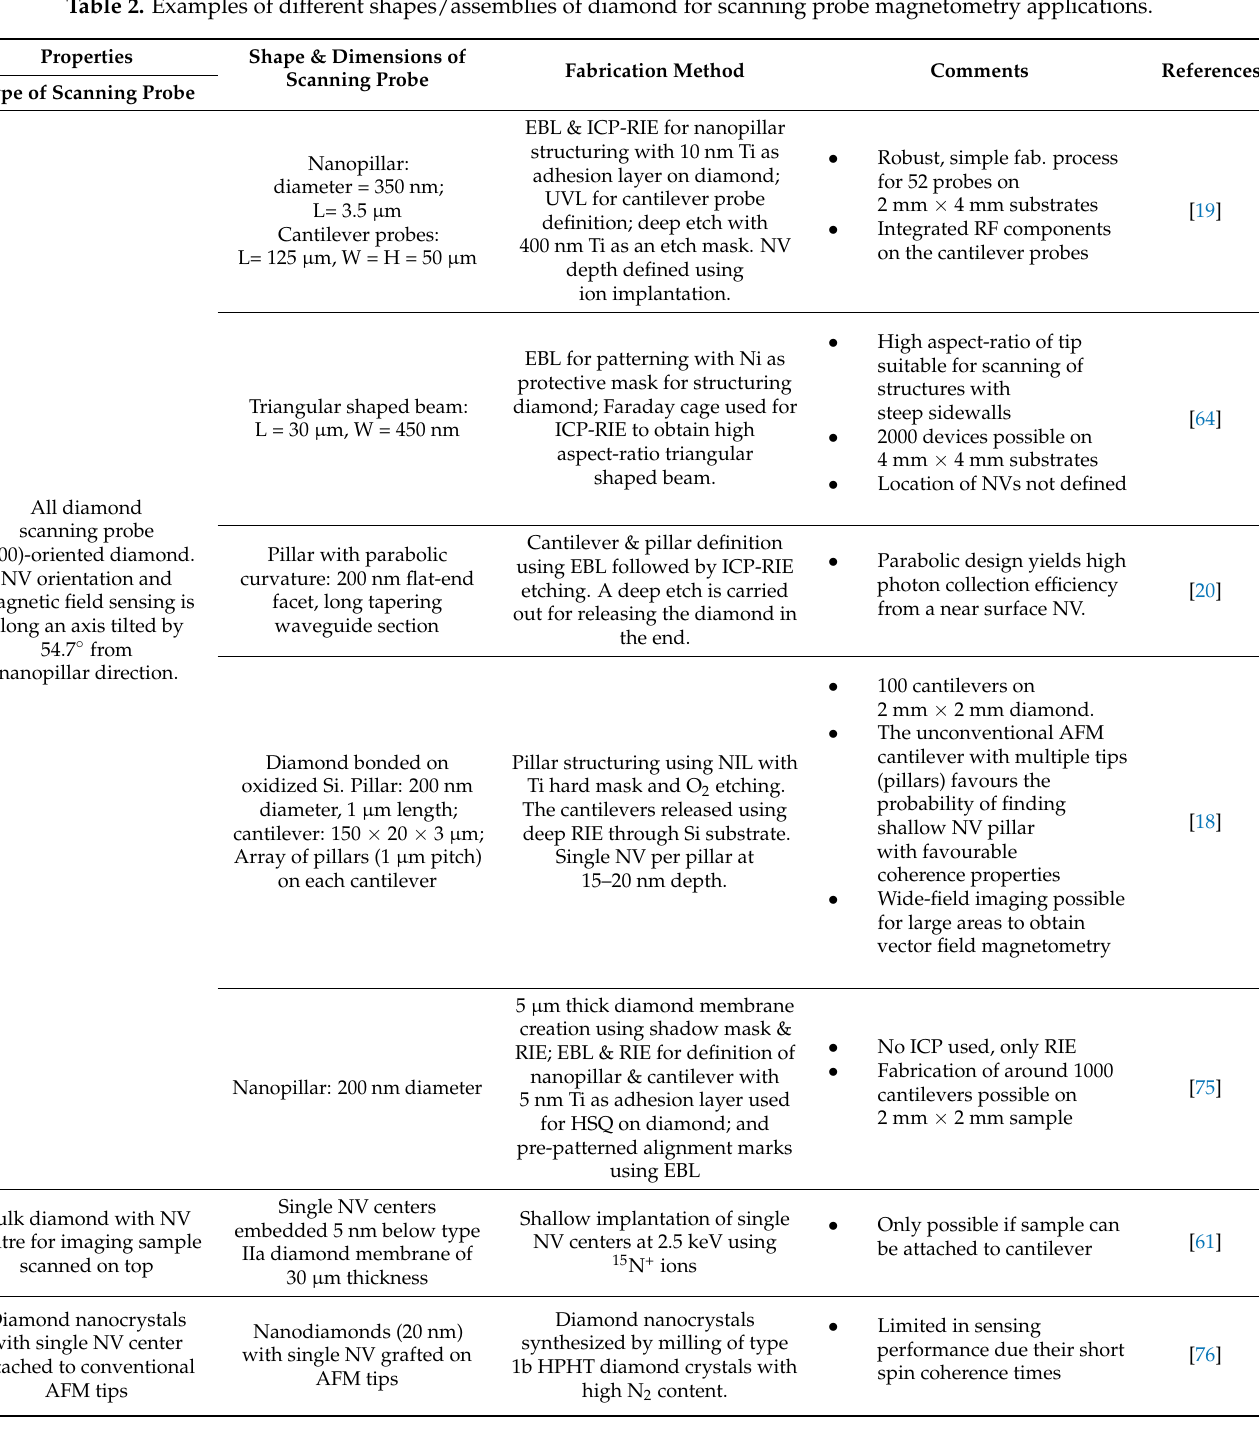
Table 2. Examples of different shapes/assemblies of diamond for scanning probe magnetometry